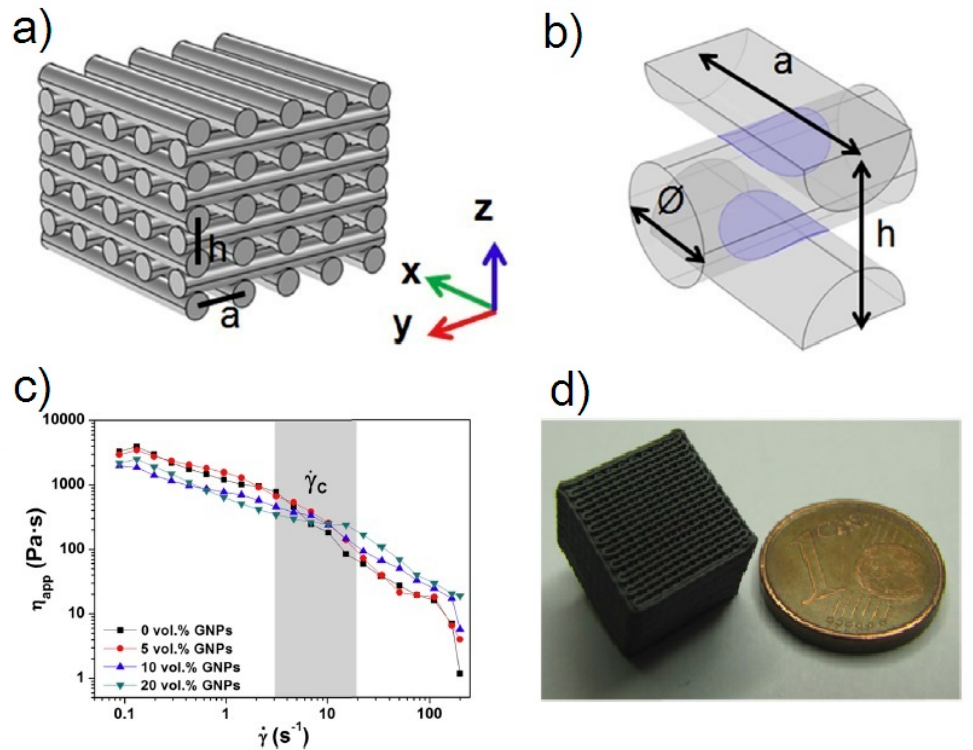
Figure 18. ( a ) Patterned structure used for scaffolds designing and ( b ) scheme of the contact area between two orthogonal rods, where h , a , and Ø correspond to the distance between two equivalent layers in the z direction, the distance between two adjacent rods, and the rod diameter, respectively. ( c ) Apparent viscosity as a function of the shear rate for the GNPs/SiC pastes formulated with 0, 5, 10 and 20 vol% GNPs in the powder compositions. ( d ) View of a 10 vol% GNPs/SiC sintered scaffold. Reproduced from [208], with permission from Elsevier, 2016.